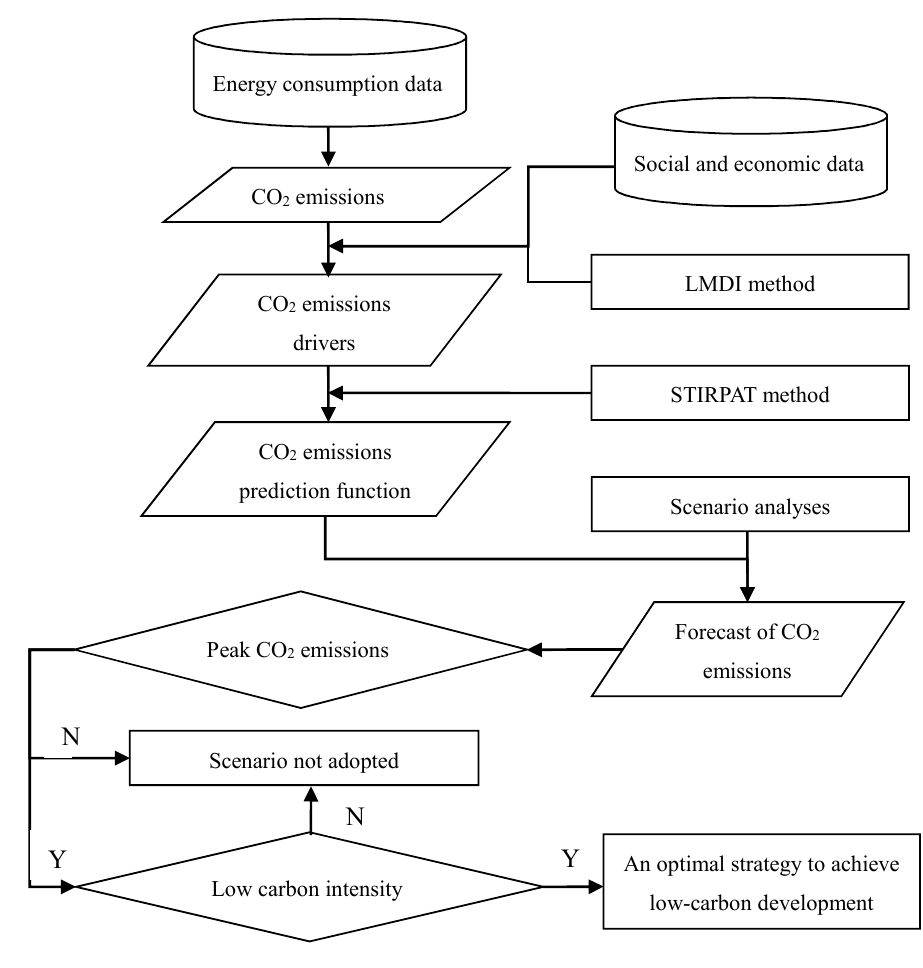
Figure 1. Technical route of the research.